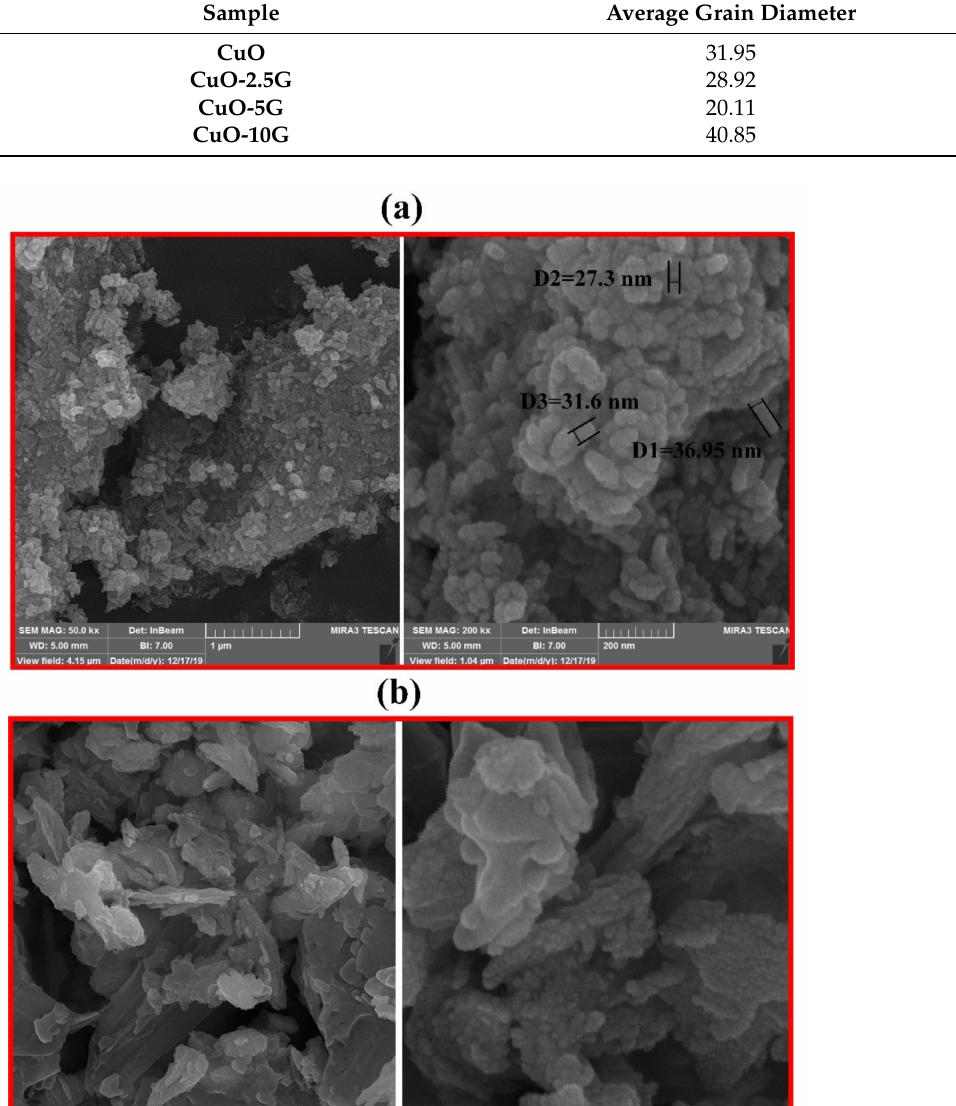
Table 4. The average grain diameter of pristine CuO, CuO-2.5G, CuO-5G and CuO-10G nanocom- posites.